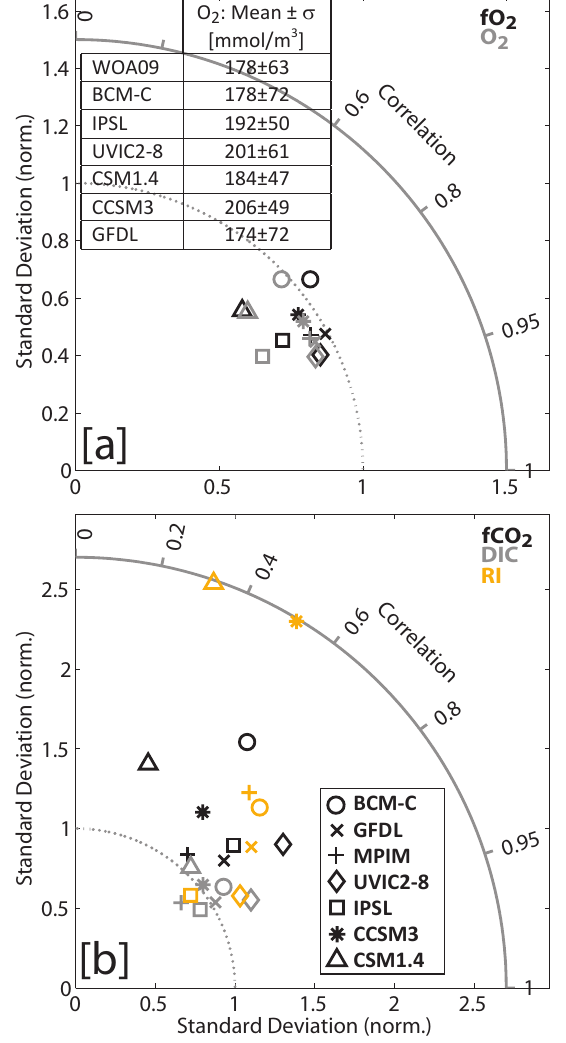
Fig. 1. Taylor diagrams: correspondence between model results (1990–1999 average) and observation-based (from GLODAP and WOA 09, annual mean) f O 2 and O 2 (a) , f CO 2 , RI, and DIC (b) . The polar coordinates represent the correlation coefficient R (polar angle) and the normalized standard deviation σ model /σ obs (radius). The results are relative to data between 100 and 600m depth and are weighted by the volume of each grid cell. Observed and modeled O 2 mean values and standard deviations ( σ ) relative to the results of (a) are summarized in the table included in (a) .